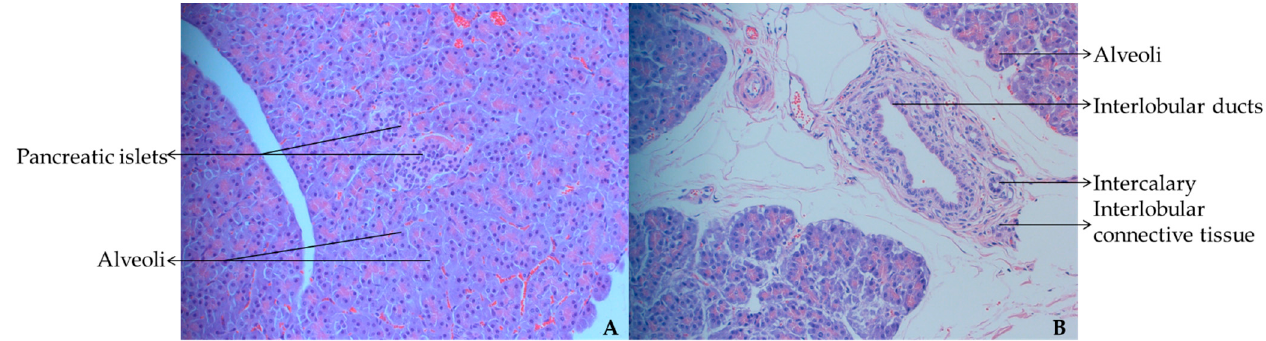
Figure 1. ( A ) Internal morphological structure of pancreatic tissue under 10× microscope; ( B ) Internal morphological structure of pancreatic tissue under 20× microscope.